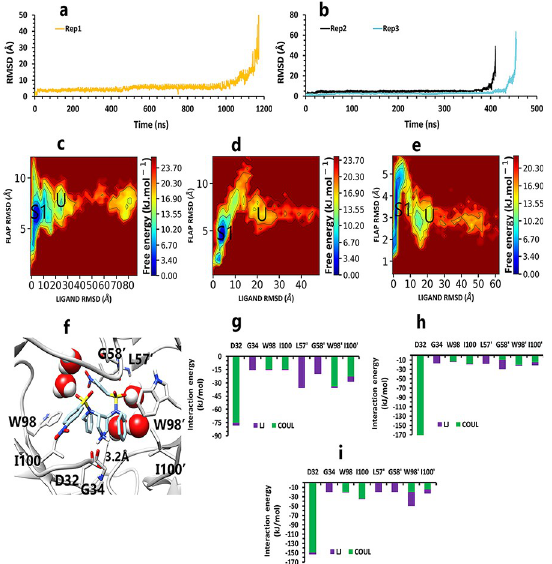
Fig 13. The details of compound 9 unbinding pathways in complex with HTLV-1 protease when Asp32 of chain B was protonated in three replicas. A , RMSD value of the ligand from binding pose to complete unbinding in the rep1. B , RMSD values of the ligand from binding pose to complete unbinding in the rep2 and rep3. C , D , and E , The free energy landscape of rep1, 2, and 3 during the unbinding process (state (S), intermediate state (I), unbound (U)), respectively, was calculated using "gmx sham". F , The interactions between the ligand and essential active site residues in the rep1, 2, and 3. G , H , and I , The average of most important interaction energies of the protein-ligand complex in rep1, 2, and 3, respectively.